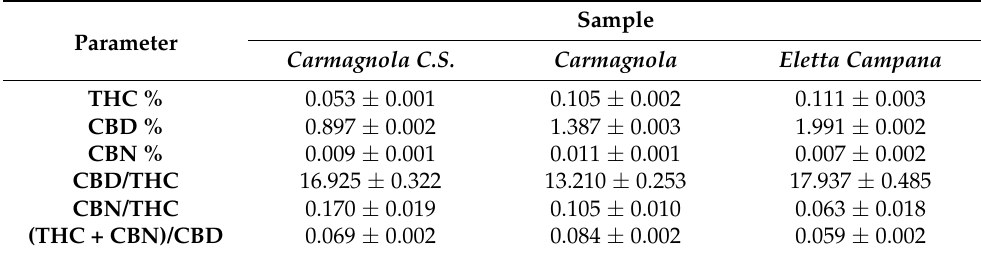
Table 2. CBD, THC, and CBN quantification and their ratios in three samples of Cannabis sativa L. Average analyte values are expressed as % (g/100 g dw) ± SD ( n = 3). The uncertainties of the ratios were calculated by applying the random errors propagation. Sample Parameter Carmagnola C.S. Carmagnola Eletta Campana THC % 0.053 ± 0.001 0.105 ± 0.002 0.111 ± 0.003 CBD % 0.897 ± 0.002 1.387 ± 0.003 1.991 ± 0.002 CBN % 0.009 ± 0.001 0.011 ± 0.001 0.007 ± 0.002 CBD/THC 16.925 ± 0.322 CBN/THC 0.170 ±